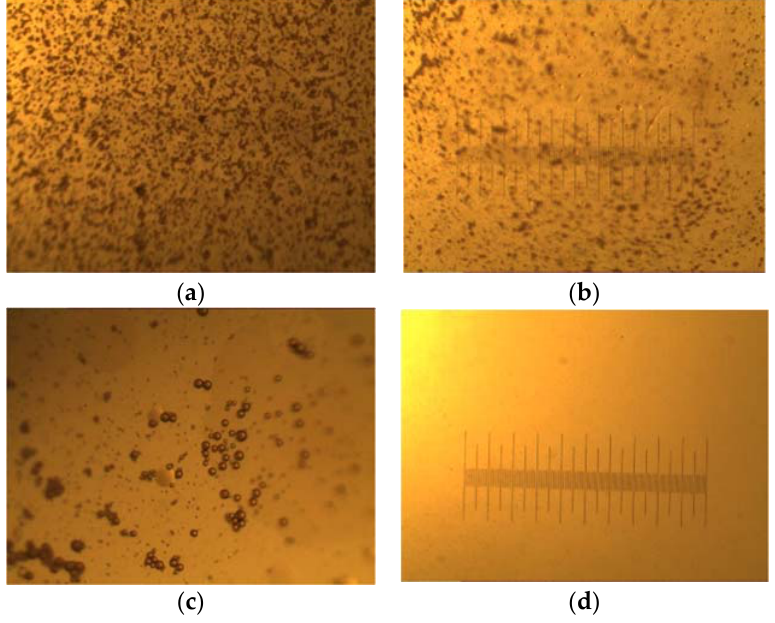
Figure 10. Micrograph of demulsification effects of different demulsifiers, of which the magnification was 40×. ( a ) Description of the sample before demulsification; ( b ) description of demulsification effect of PDMDAAC (0.32 dL/g); ( c ) description of demulsification effect of BQ ‐ 05; ( d ) description of demulsification effect of poly (DMDAAC ‐ co ‐ DAMBAC) (9:1).